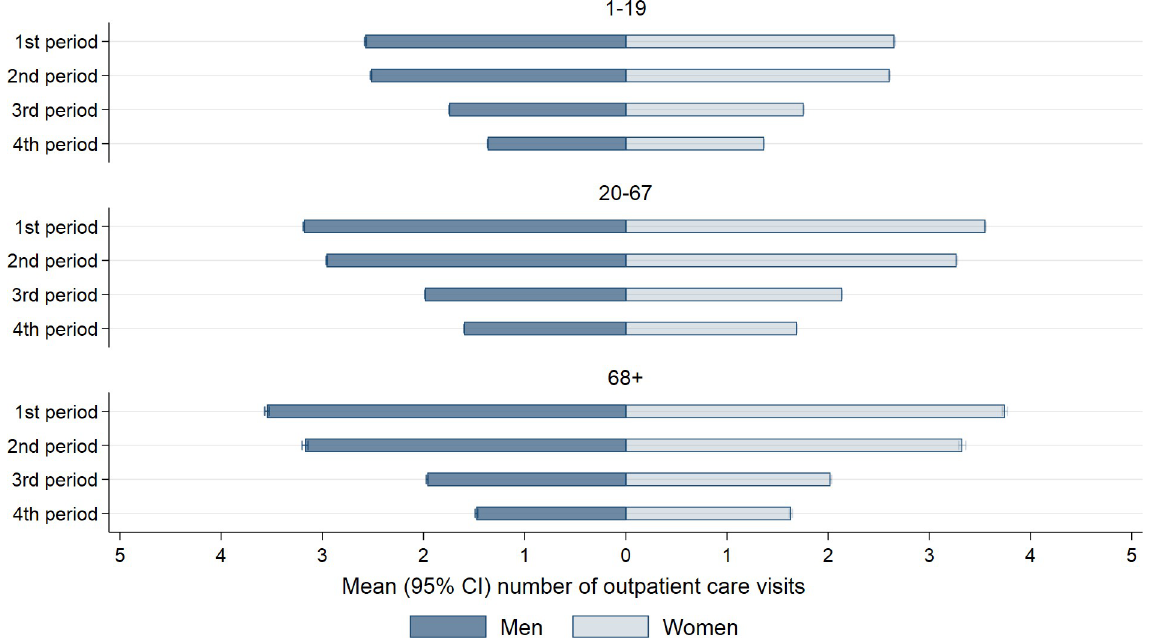
Fig 3. Number of outpatient care visits. The mean (95% confidence intervals) number of visits in outpatient care, for women and men in different age groups, four waves/periods of the pandemic: February 26 th , 2020 –February 16 th , 2021 (1 st period), February 17 th , 2021 –July 10 th , 2021 (2 nd period), July 11 th , 2021 –December 27 th , 2021 (3 rd period), and December 28 th , 2021 –January 14 th , 2022 (4 th period), among persons having at least one visit in outpatient care.